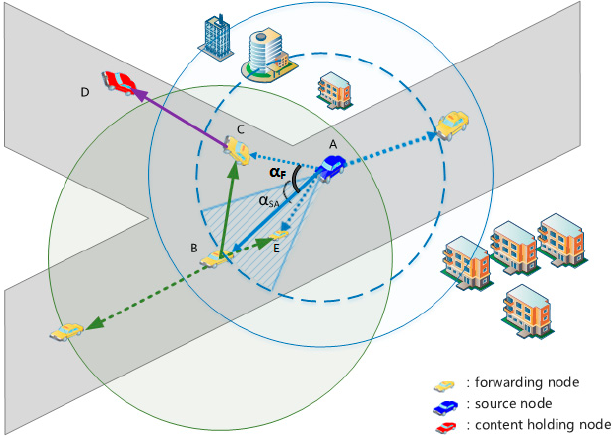
Figure 7. Suppression angle and scope in the distance-based forwarding.